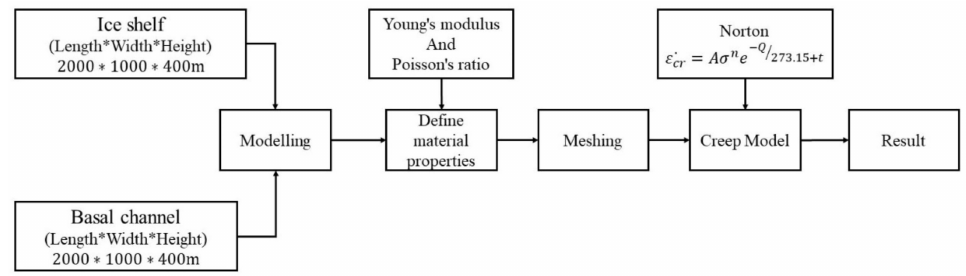
Figure 2. Creep simulation